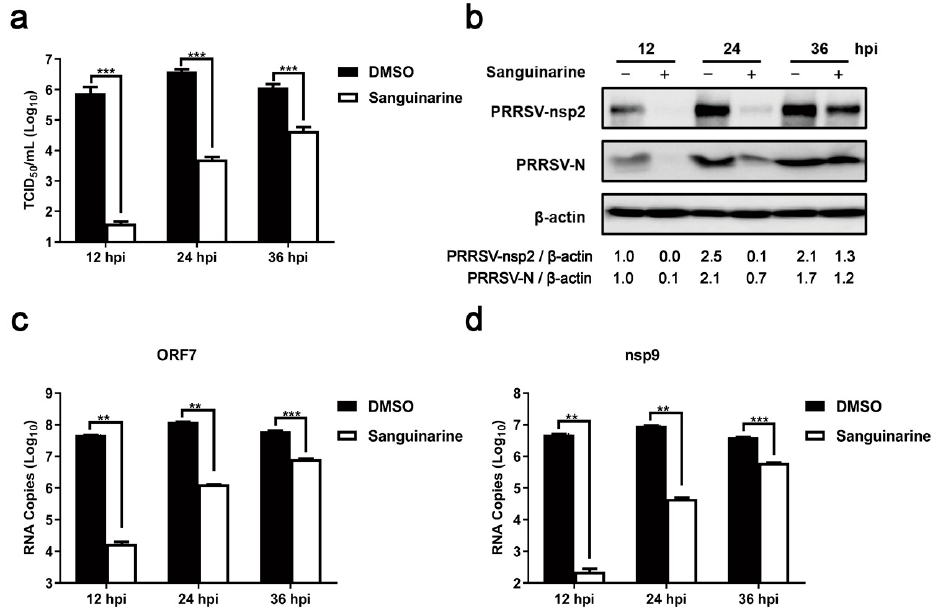
Figure 2. Sanguinarine significantly restricts PRRSV infection. MARC-145 cells were incubated with sanguinarine (0.80 µ g/mL) and PRRSV (MOI = 0.5) as described in 2.9 of the Section 2. The group treated with DMSO was set as a negative control. Then, the viral titers, protein levels of PRRSV N/nsp2, and mRNA levels of PRRSV ORF7/nsp9 were evaluated by TCID 50 assay ( a ), Western blot assay ( b ), and RT-qPCR ( c , d ) at 12, 24, and 36 hpi, respectively. ( b ) The ratios of nsp2/ β -actin and N/ β -actin were analyzed using ImageJ. ( a , c , d ) Data are expressed as the means and standard deviations from three independent experiments and analyzed using two-way ANOVA. **, 0.001 ≤ p < 0.01; ***, p < 0.001.